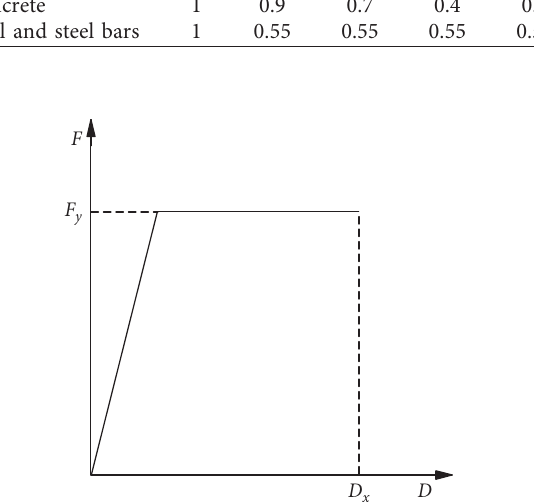
Figure 8: Relationship of F-D for steel and reinforcements.